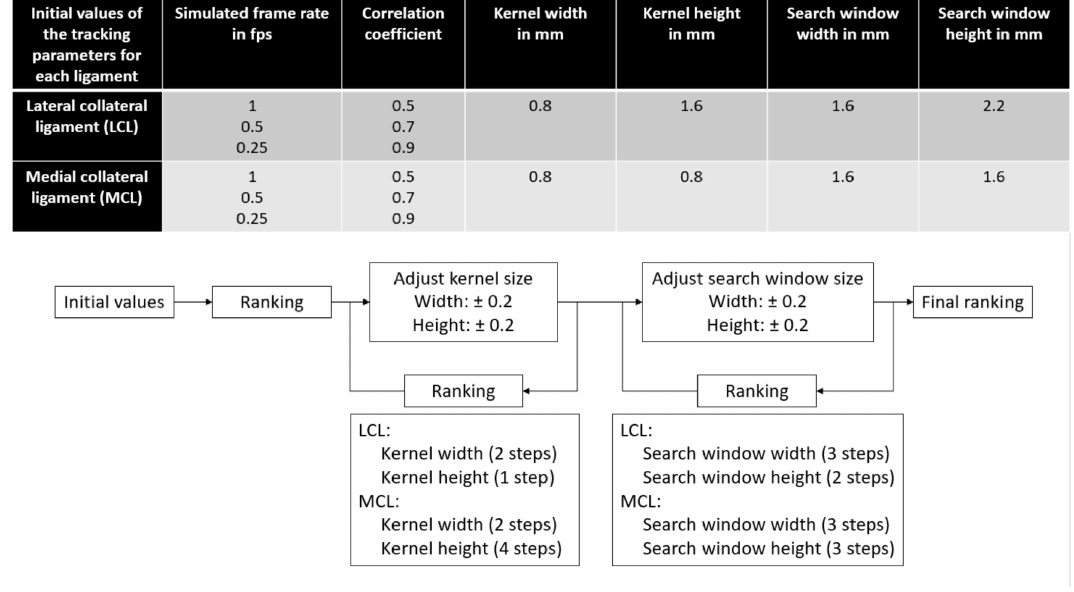
Figure 5. Tracking parameter values selection during optimization. Ultrasound data were first processed with initial values based on a previous study [5]. Afterwards, results were ranked, the dimensions of the kernel were modified around the best results and the ultrasound data were processed again. This processed was iterated until no improvement in the results were observed. Then, this whole iterative process was repeated similarly for the search window dimensions. Once this iterative process was over, a final ranking was performed to obtain the optimal parameter set for each ligament. fps: frames per